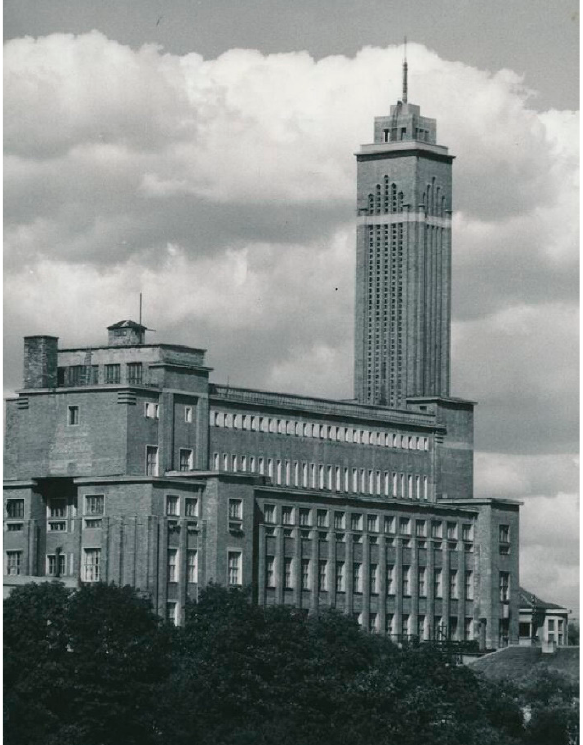
Figure 10. Christ’s Resurrection Church reconstructed into a factory building (photographer Stanislovas Lukošius, 1964, source: Kaunas City Museum).